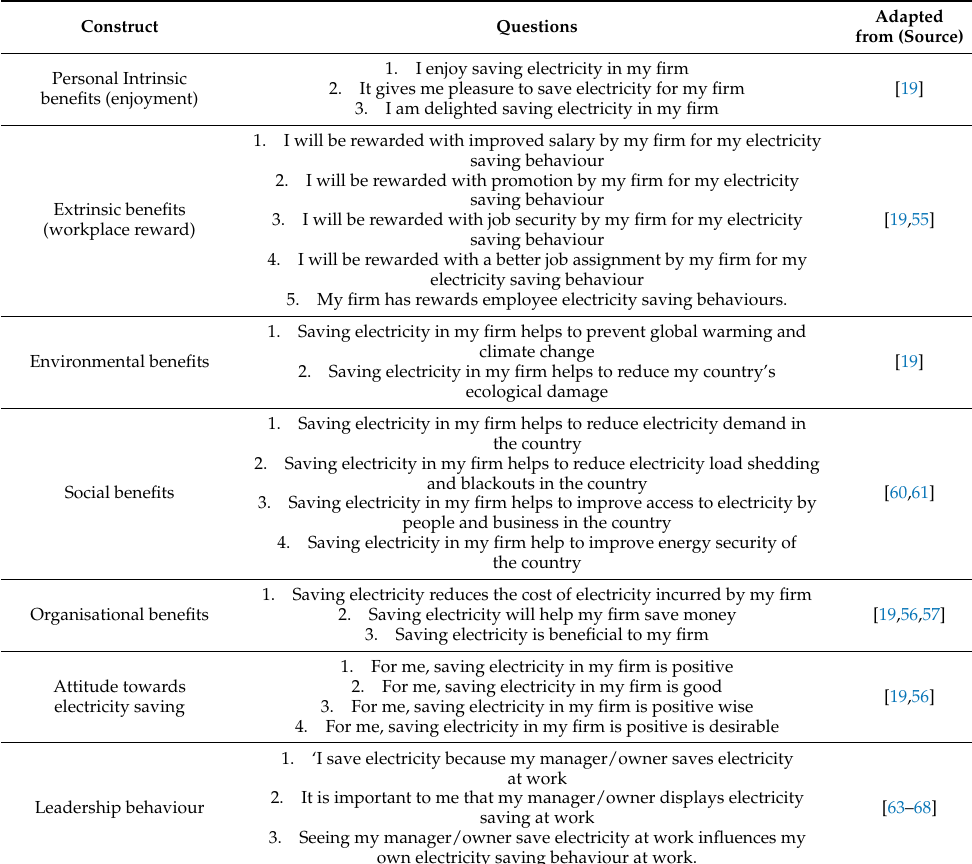
Table A1. Measures of the constructs of the